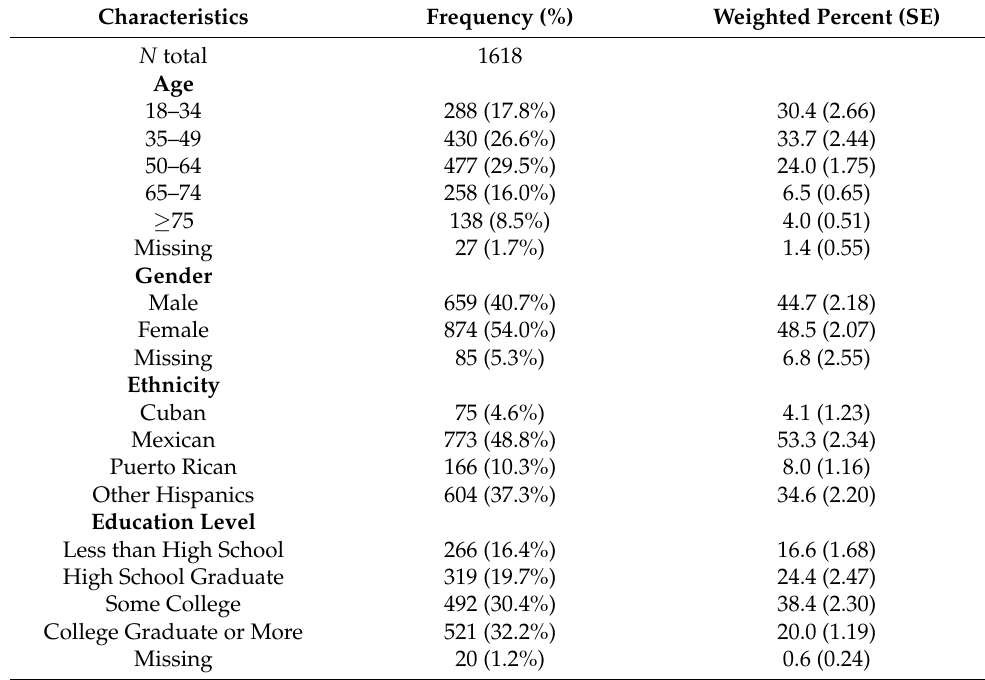
Table 1. Demographic and smoking characteristics of Hispanic respondents in 2017–2019 HINTS ( N =